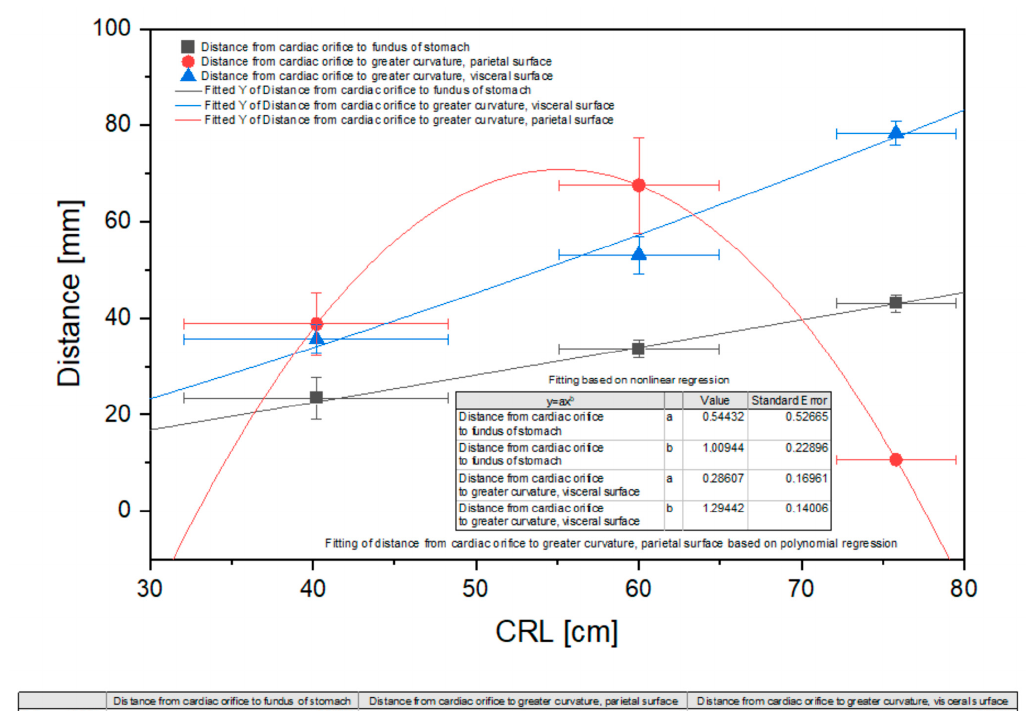
Figure 10. Nonlinear regression of the stomach morphometric values (distance from the cardiac orifice to the stomach fundus, from the cardiac orifice to the greater curvature and the parietal surface, and distance from the cardiac orifice to the greater curvature and the visceral surface). CRL—crown-rump length.